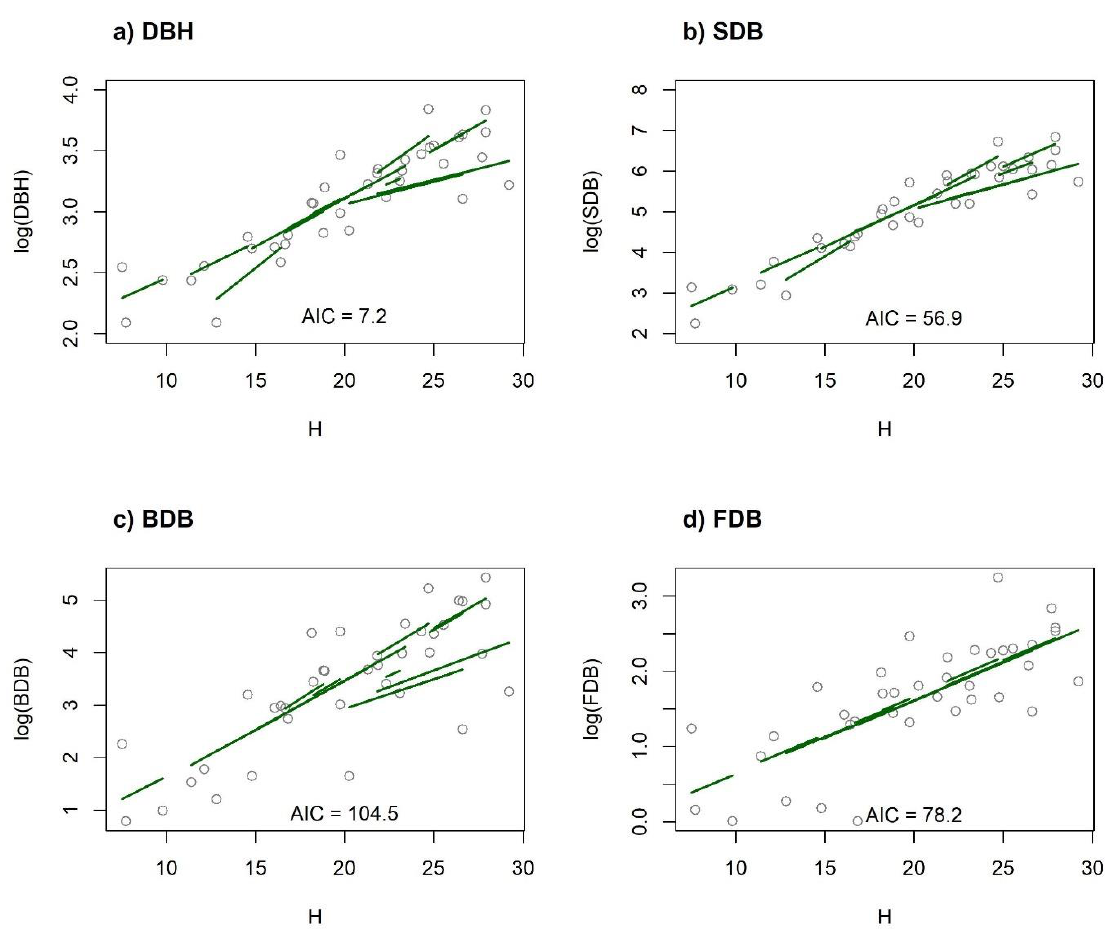
Figure 3. Individual mixed-effect models (second approach) for diameter at breast height (DBH, ( a )), stem dry biomass (SDB, ( b )), branches dry biomass (BDB, ( c )), and foliage dry biomass (FDB, ( d )) as dependent variables with height (H) as independent variable.